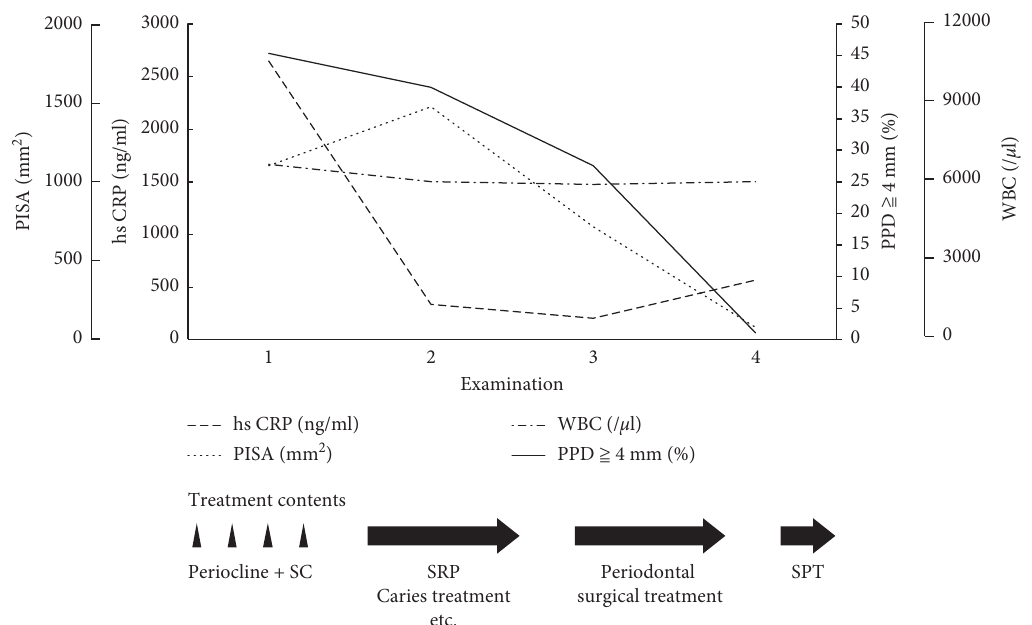
Figure 3: The course of dental treatment and the changes in hs-CRP levels, WBC, PISA value, and the ratio of PPD > 4 mm. As periodontal treatment advanced, the value of inflammatory markers showed a decreased